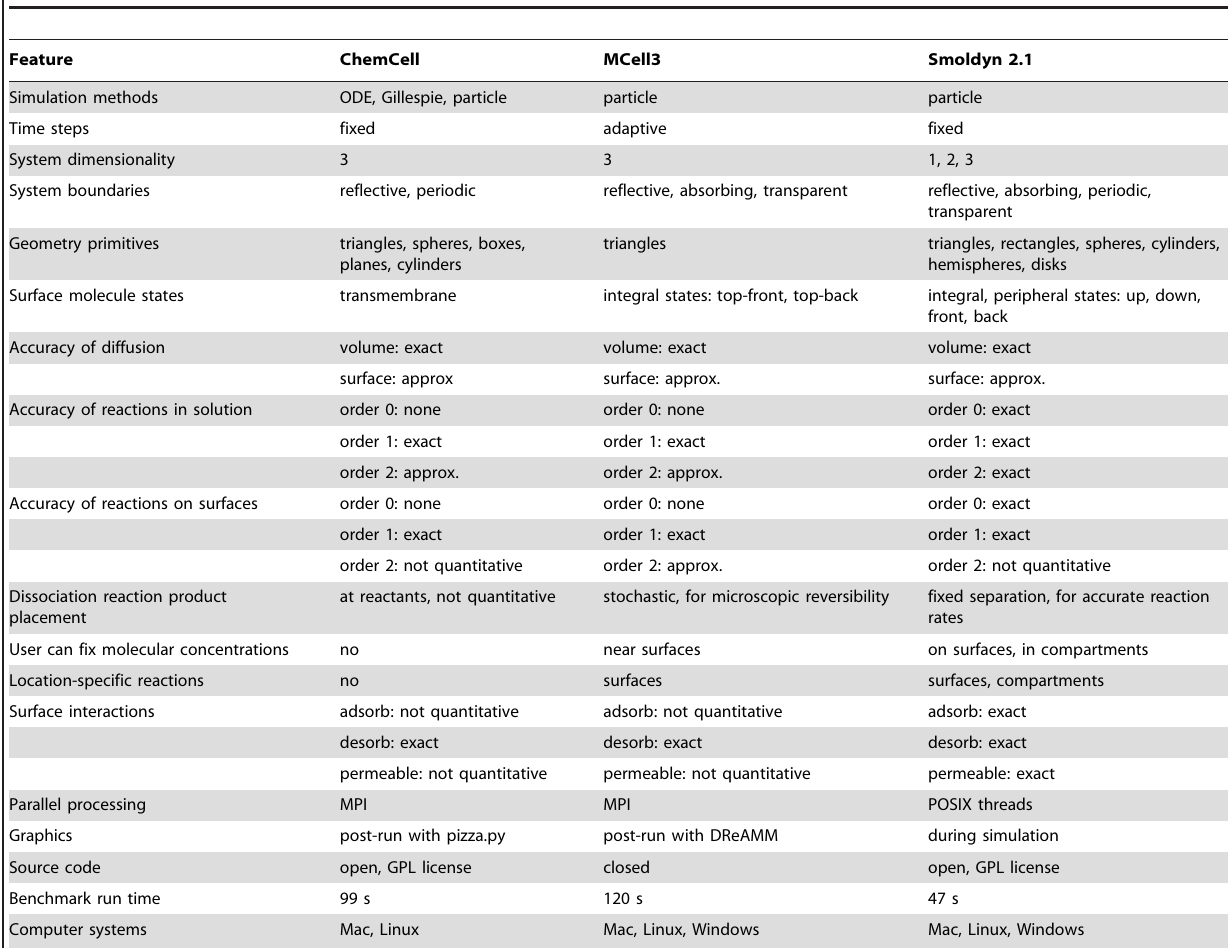
Table 2. Comparison of current particle-based